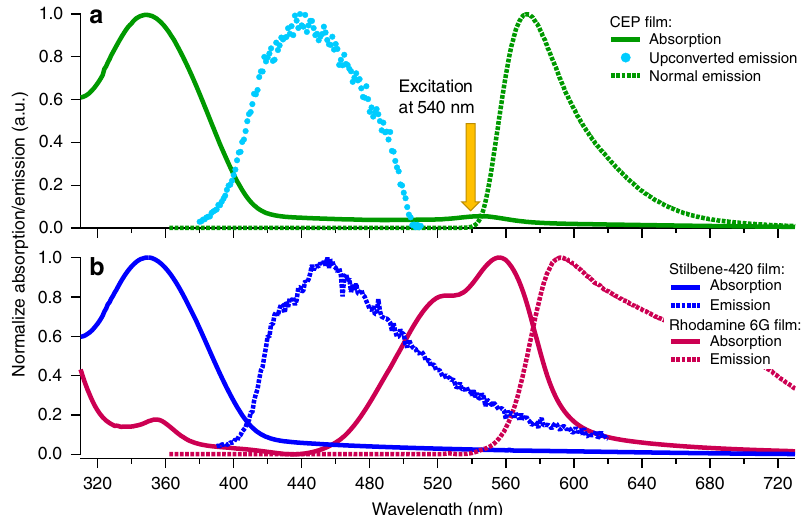
Figure 2 | Spectral properties of the materials in this work. ( a ) Absorption, emission and upconverted emission spectra of Rhod6G/Stilb420 blend CEP film. Upconverted emission was measured under 540nm excitation. Normal emission was measured under excitation at 349nm to avoid artifacts due to scattered excitation signal overlapping with emission spectrum. ( b ) Absorption and emission spectra of pristine Stilbene-420 (acceptor) and Rhodamine 6G (sensitizer) chromophores in thin films. Emission spectra were measured under excitation at 363 and 525nm for Stilbene-420 and Rhodamine 6G,